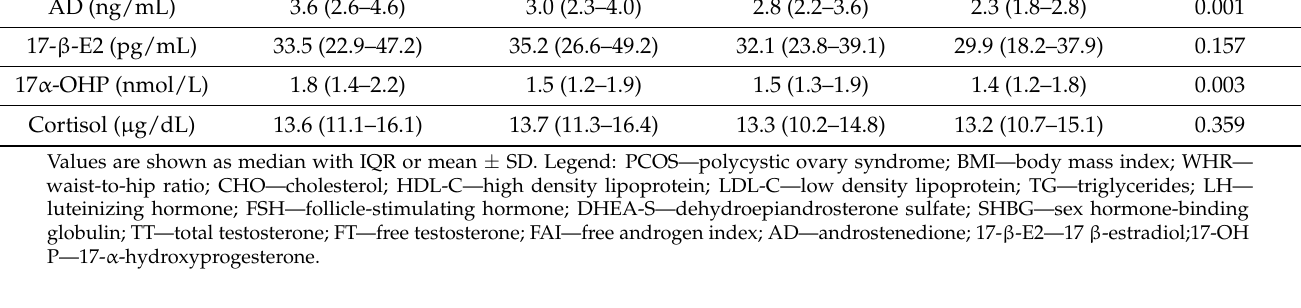
Table 2. Investigated parameters in the subgroups divided according to the value of